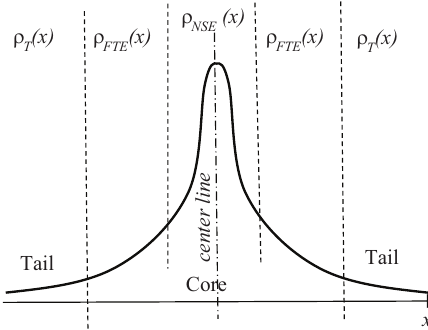
Figure 1. Components of triple probability density distribution